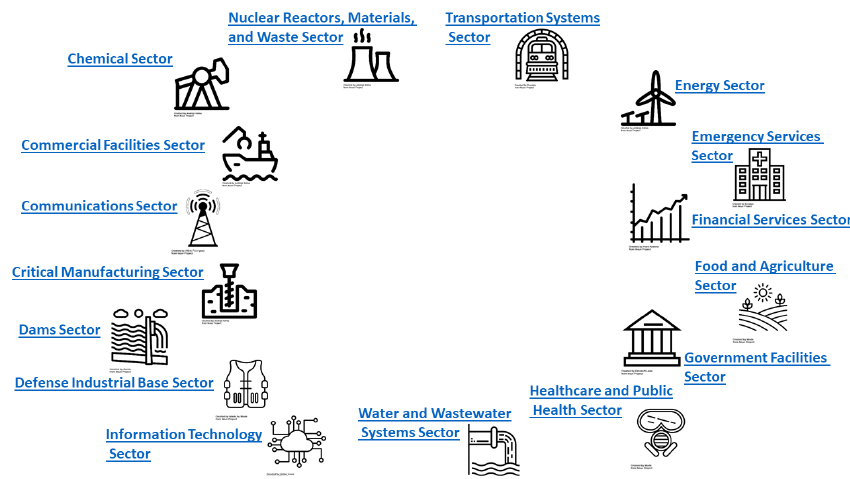
Figure 1. Critical Infrastructure